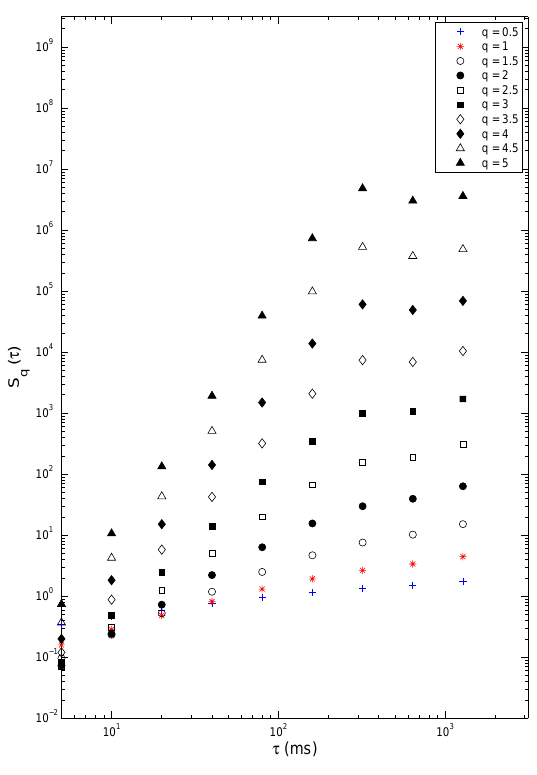
Fig. 1. Plots of S q (τ) vs. τ generated from measured electric field fluctuations in the auroral zone at selected moment order q